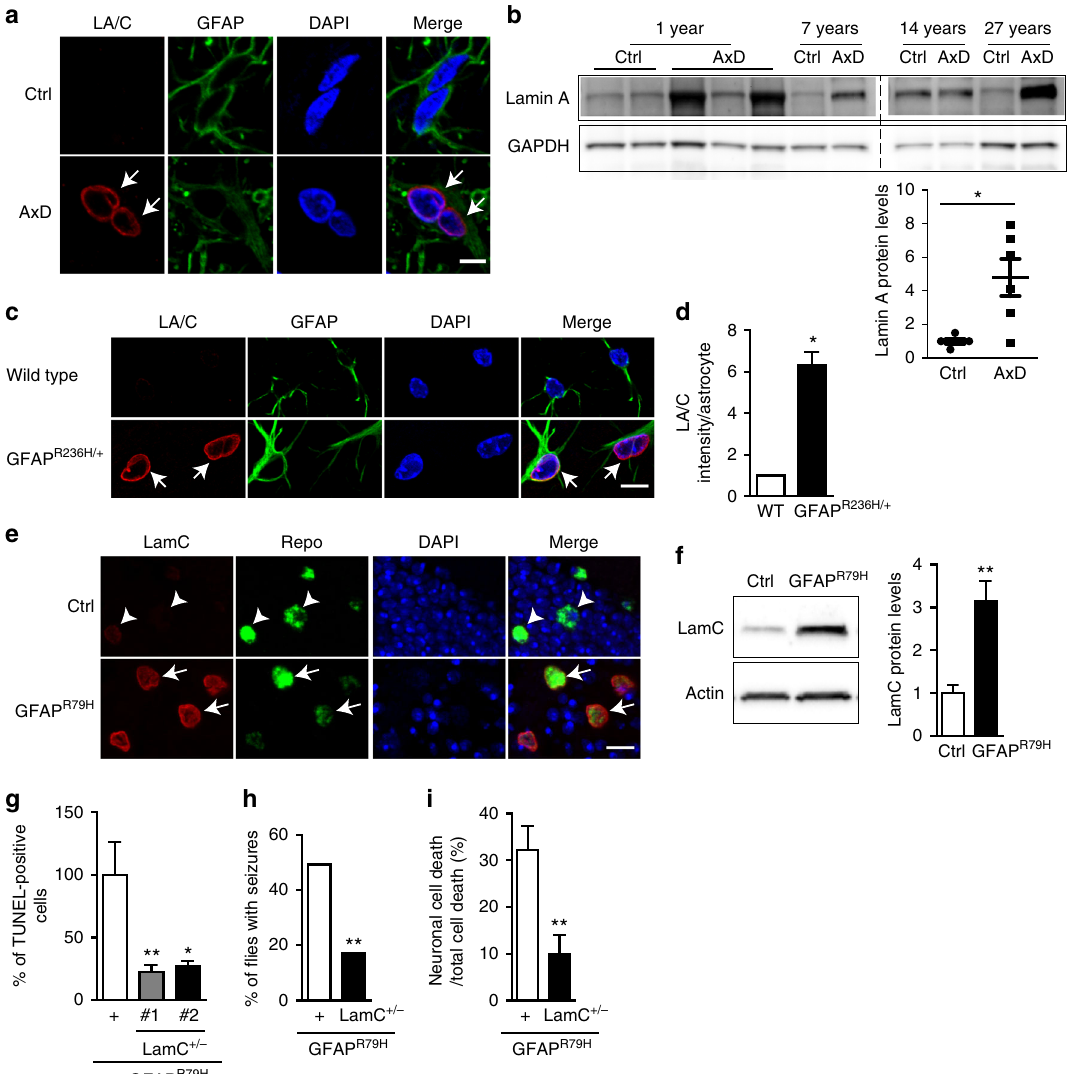
Fig. 2 Increased expression of A-type laminin Alexander disease. a Double label immuno fl uorescence shows increased A-type lamin, lamin A/C (LA/C) expression in the astrocytes of a 1-year-old Alexander disease patient (AxD, arrows) compared to an age-matched control (Ctrl). GFAP labels astrocytes. Scale bar is 5 microns. b Western blots con fi rm a signi fi cant increase of lamin A expression in the white matter of Alexander disease patients compared to age-matched controls. The blots are reprobed for GAPDH to illustrate equivalent protein loading. p = 0.0476, Mann – Whitney test. c Double label immuno fl uorescence shows increased lamin A/C (LA/C) expression in the astrocytes of 3-month-old Alexander disease model mice ( GFAP R236H / + , arrows) compared to age-matched wild-type littermate control (wild type). GFAP labels astrocytes. Scale bar is 10 microns. d Quanti fi cation of immuno fl uorescence intensity shows marked increase of lamin A/C expression in 3-month-old Alexander disease model mice ( GFAP R236H / + ) compared to age-matched wild-type mice (WT). N = 3 animals per genotype. A total of 30 astrocytes per animal were used for quanti fi cation. p = 0.0126, Wilcoxon test. e Double label immuno fl uorescence demonstrates increased expression of LamC, the Drosophila homolog of A-type lamin, in the glial cells of Alexander disease model fl ies (GFAP R79H , arrows) compared to age-matched control fl ies (Ctrl, arrowheads). Repo marks glial cells. Scale bar is 5 microns. f Western blot demonstrates increased expression of LamC in Alexander disease model fl ies compared to age-matched controls. The blot is reprobed for actin to illustrate equivalent protein loading. N = 8, p = 0.0002, Mann – Whitney test. g Reducing LamC expression using two loss-of-function alleles of LamC in Alexander disease model fl ies markedly reduced cell death measured by TUNEL analysis. N = 6 per genotype. * p < 0.05, ** p < 0.01, Kruskal – Wallis test. h Reducing LamC expression using a loss-of-function allele of LamC in Alexander disease model fl ies signi fi cantly decreased the number of fl ies with seizures. N > 100 per genotype. p < 0.001. χ 2 -test. i Reducing LamC expression using a loss-of-function allele of LamC in Alexander disease model fl ies rescues non-cell autonomous neuronal cell death. N = 6 per genotype. p = 0.0152, Mann – Whitney test. Flies are 20 days old in e – g , i and 1 day old in signaling rescues function and viability of neurons in vivo. Fur- postmortem human brain tissue and experimental models of ther, we demonstrate directly that brain stiffness is increased in Alexander disease, including an Alexander disease-linked mutant the mouse model of Alexander disease. Taken together, these GFAP knock-in mouse model 11 , a Drosophila model of Alexander fi ndings provide strong support for a causative role for perturbed disease 21 and patient-speci fi c astrocytes. We identify pervasive glial mechanotransduction in promoting brain dysfunction in misregulation of mechanotransduction signaling pathways in astrogliopathy. Alexander disease, and show that genetic correction of these